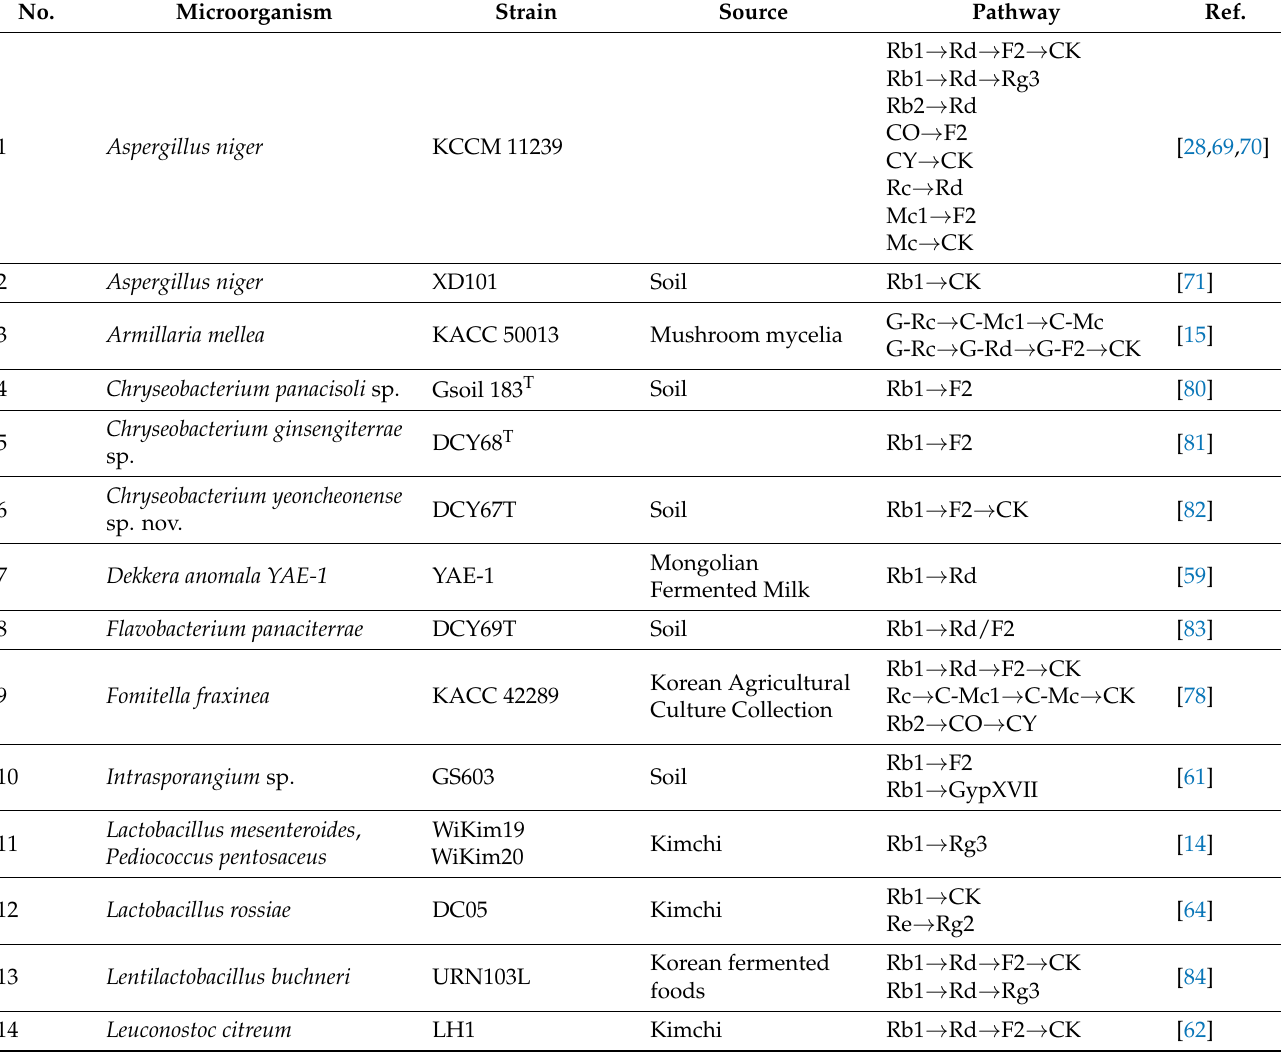
Table 1. Bioconversion of ginsenosides by whole-cell protein extraction from microorganisms. Strain Source Pathway